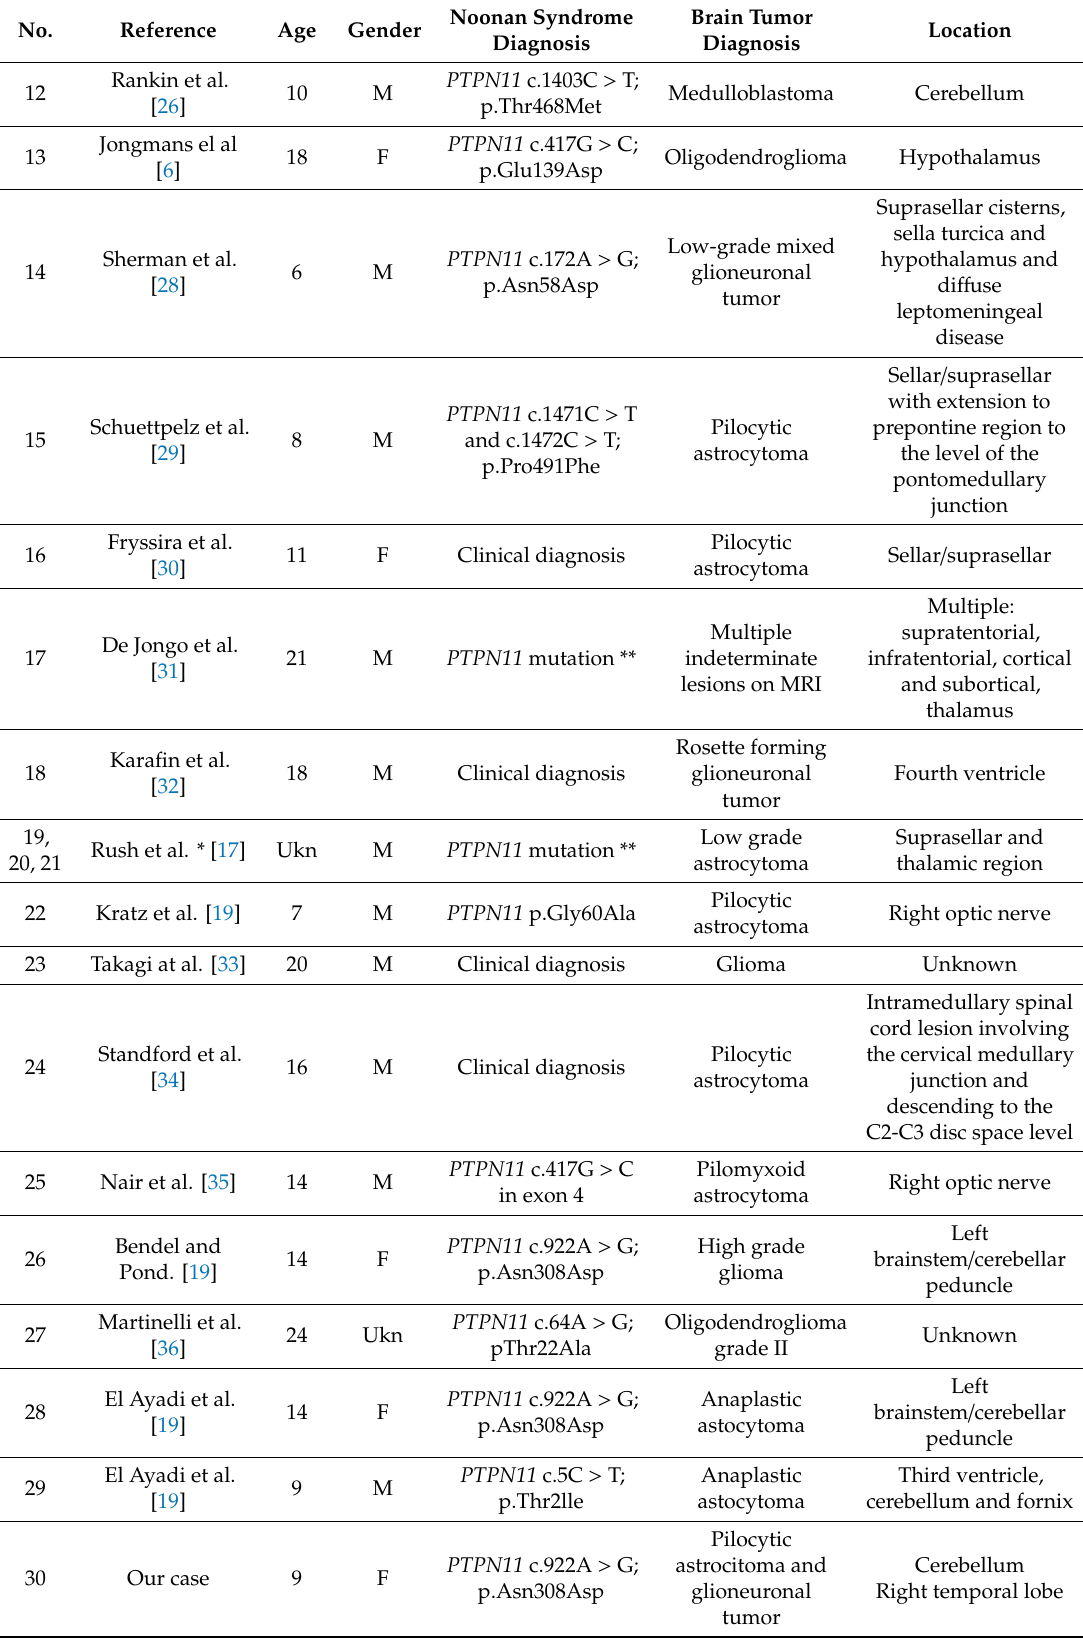
* patients 19, 20 and 21 were from a case series abstract of two males and one female. Two patients were deaf and possibly had NSML. DNET—dysembryoplasic neuroepithelial tumor. ** Mutation